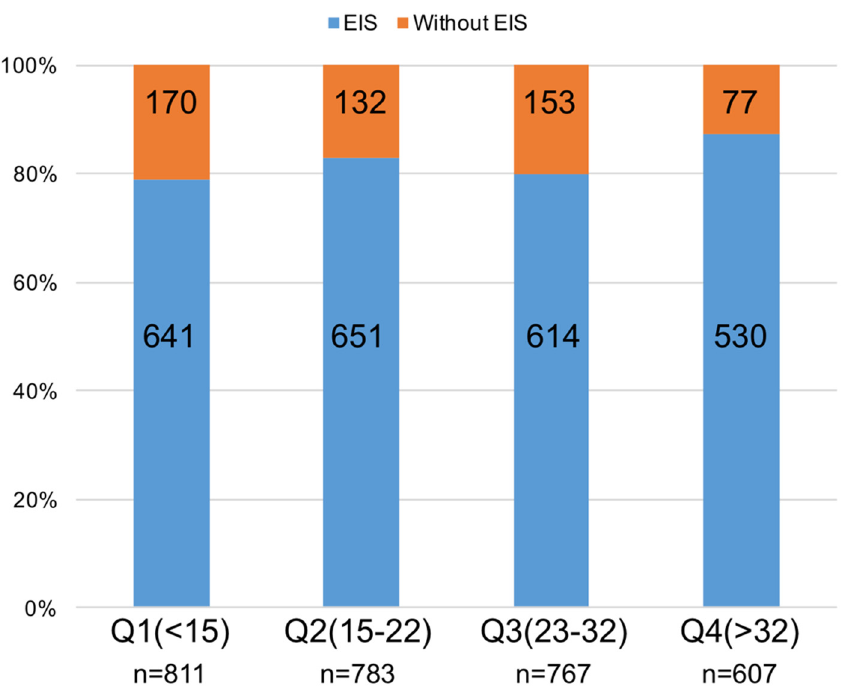
Figure 2. Percentages of patients treated with an early invasive strategy, according to NCDR CathPCI risk score quartiles. Abbreviations: EIS, early invasive strategy; NCDR, national cardiovascular data registry.